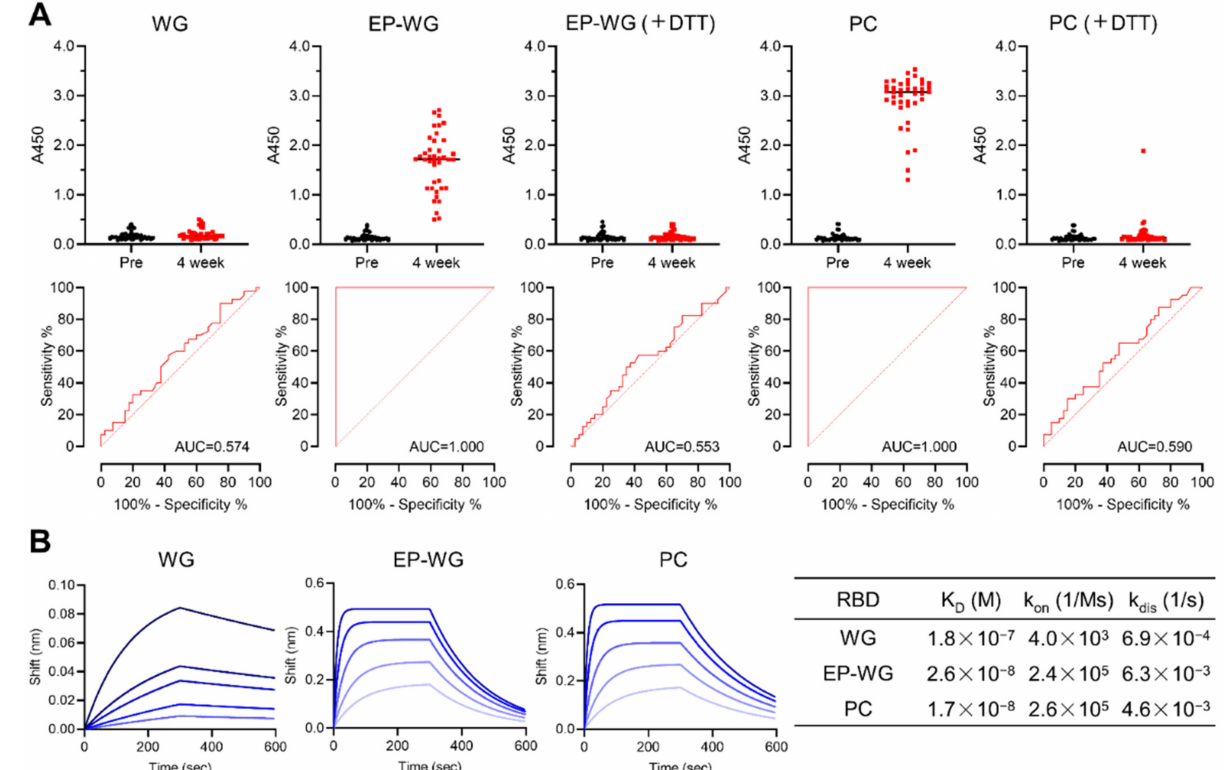
Figure 2. Characterization of disulfide-bonded RBD protein synthesized by wheat germ cell-free pro- duction system. ( A ) Antigenicity of disulfide-bonded RBD protein produced by wheat germ cell-free protein synthesis system with ERO1 α and PDI (EP-WG). Each protein was incubated with or without 100 mM of DTT for 30 min at 37 ◦ C and then subjected to ELISA using pre- or post-vaccinated serum (4 weeks after vaccination). The commercially available RBD protein produced by the mammalian cell expression system was used as a positive control (PC). The receiver operator characteristic (ROC) curves were constructed and the areas under the curves (AUCs) were calculated. ( B ) The K D of each RBD against ACE2. Biotinylated ACE2 was immobilized on the streptavidin biosensor and then analyzed for association with each RBD protein at various concentrations (1600, 800, 400, 200 and 100 nM for WG, and 400, 200, 100, 50 and 25 nM for EP-WG and PC) by OctetRED96 instrument.